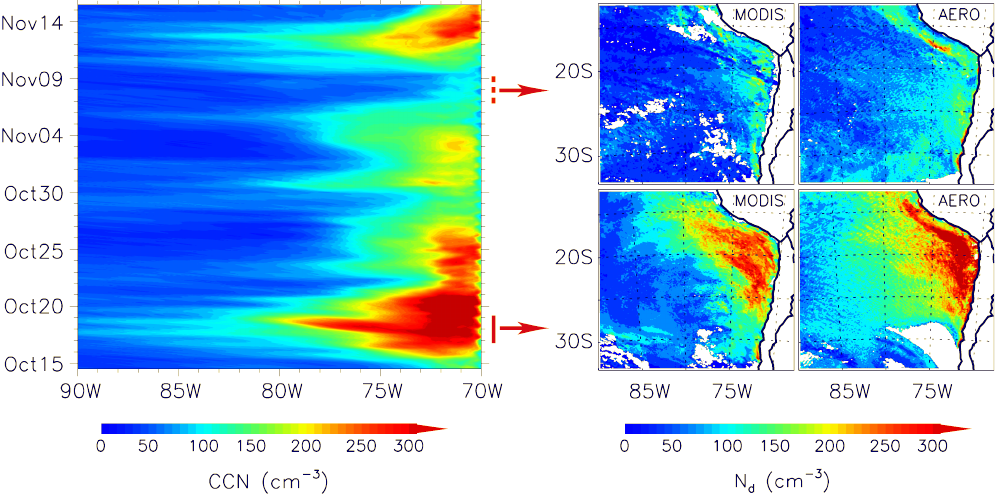
Fig. 4. Longitude-time plot of model (AERO) predicted CCN (at 0.1% supersaturation) concentrations at 975hPa along 20 ◦ S ( ± 2.5 ◦ in latitude), and illustration of episodic horizontal distribution of MODIS-derived (Aqua) cloud droplet number concentration (N d ) and AERO- predicted cloud top N d during a strong outflow event (peaks on 18 October 2011, red solid line) and during a clean period (around 8 November 2011, red dash line). To obtain a more complete data coverage over the domain, MODIS N d was composed from available retrievals in 3 days (centered at the peak of the event), and correspondingly only model predictions at around satellite overpass time (18:00–20:00 UTC) during the 3-day period are